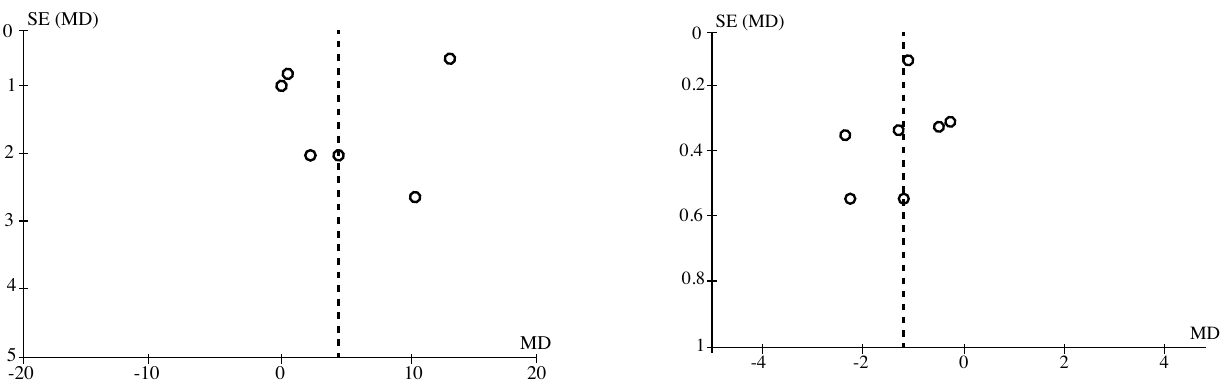
Figure 9. Funnel plot of the seven results of the five selected studies for agility measured through the “Sitting, walk 2.44m go back and sit” test (s) from the Rikli Jones test battery. The Egger test was performed with bias = -7.063103 (95% CI = -11.12332 to -3.002886) P =